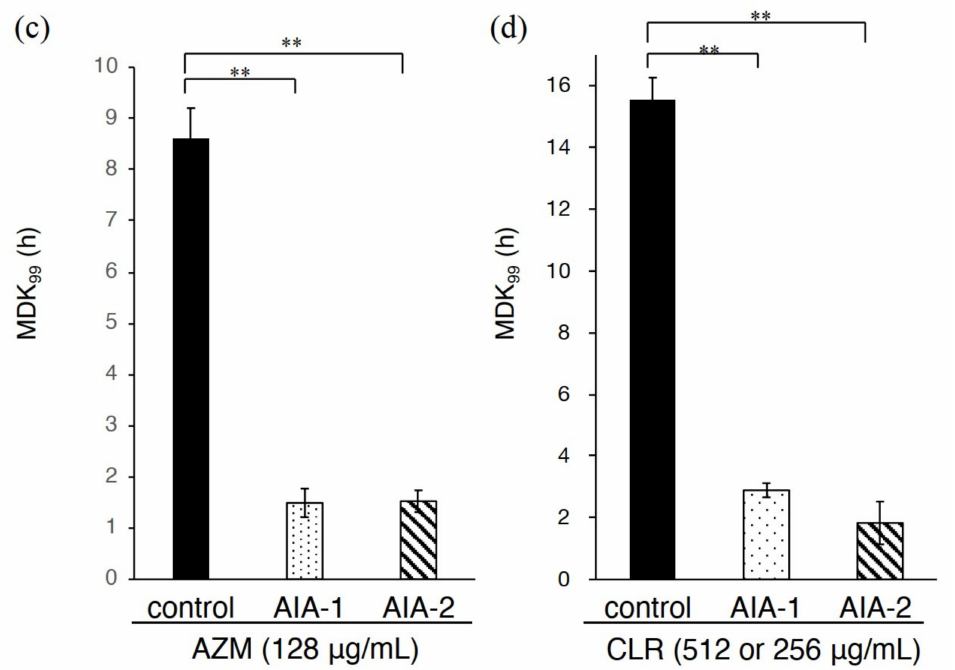
Figure 2. Time-kill assay for PAO1. ( a ) Time-kill assay for PAO1 in the presence of azithromycin at 256 µ g/mL with or without AIA-1 and -2 at 32 µ g/mL. Azithromycin alone, filled circle on the solid line; azithromycin with AIA-1, a filled square on the dotted line; azithromycin with AIA-2, filled triangle on the dashed line. ( b ) Time-kill assay for PAO1 in the presence of clarithromycin at 512 or 256 µ g/mL with or without AIA-1 or -2 at 32 µ g/mL. Clarithromycin alone, a filled circle on the solid line; clarithromycin with AIA-1, filled square on the dotted line; clarithromycin with AIA-2, filled triangle on the dashed line. MDK 99 was determined by measuring the time to kill 99% of the population with azithromycin at 256 µ g/mL with or without AIA-1 and -2 at 32 µ g/mL ( c ) and clarithromycin at 512 or 256 µ g/mL with or without AIA-1 and -2 at 32 µ g/mL ( d ).